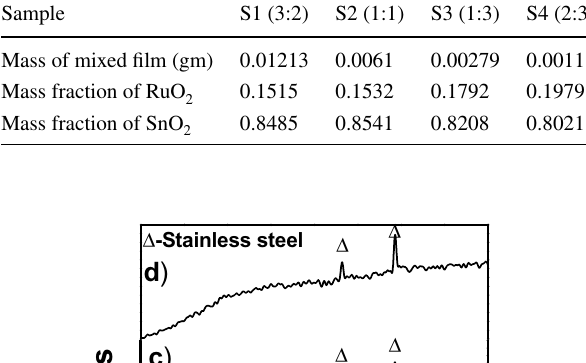
Table 1 Mass and mass fraction of SnO ent cycle ratio Sample